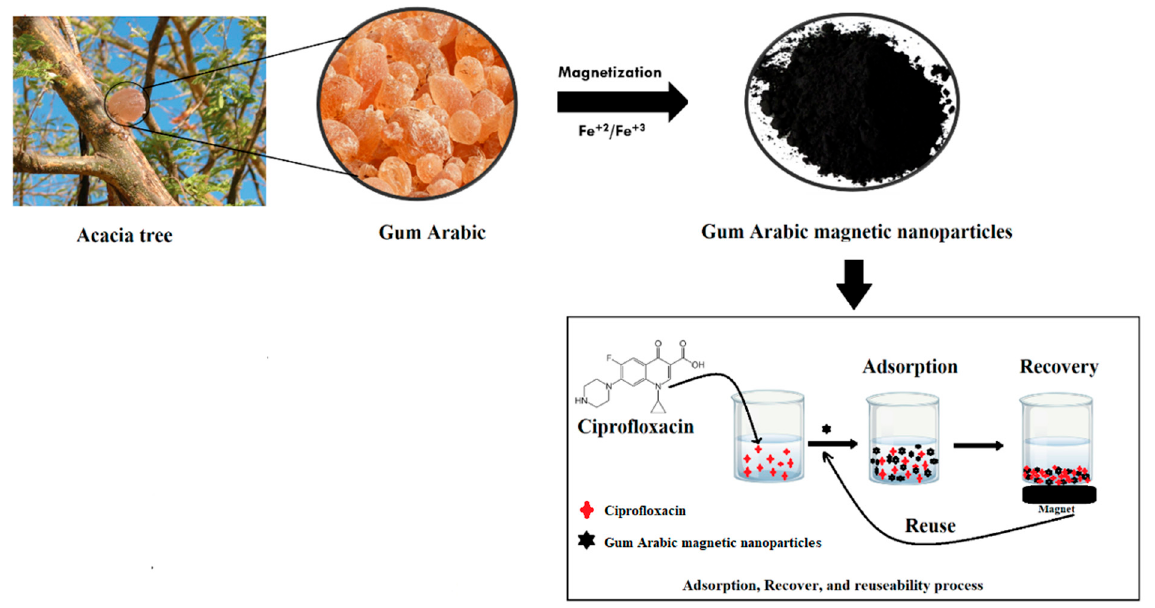
Figure 1. Synthesis of Gum Arabic Magnetite and the adsorption study process.